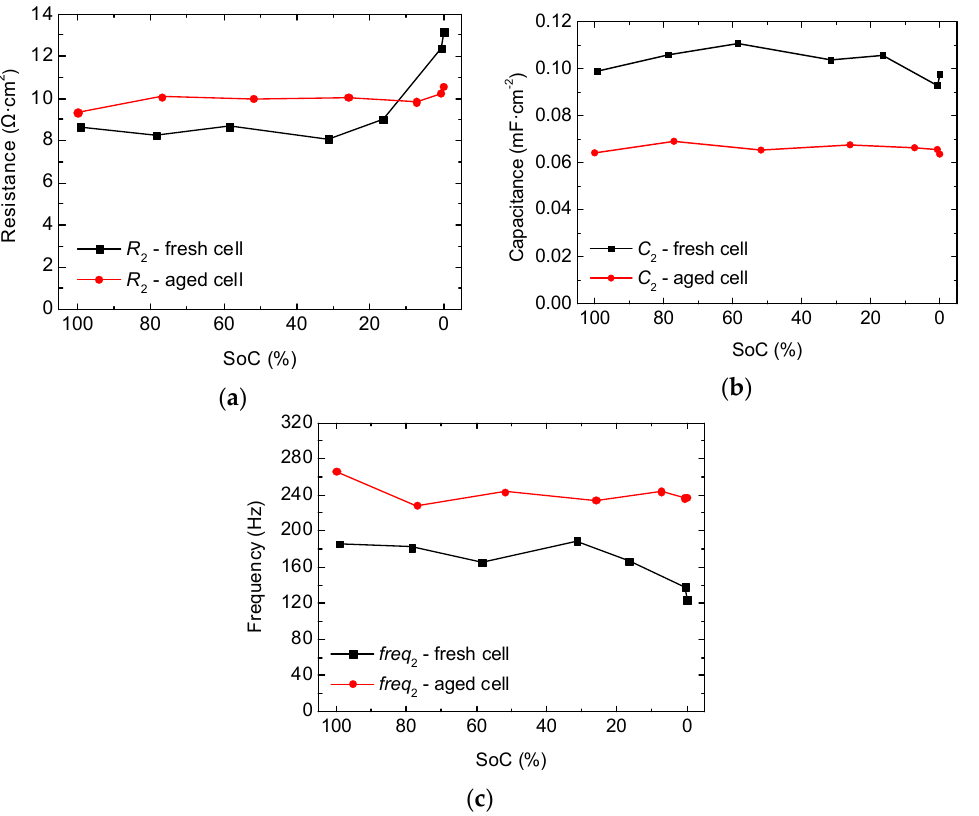
Figure 12. ( a ) Resistance, ( b ) capacitance, and ( c ) characteristic frequency related to P2_FC measured at the LCO-NMC/graphite full-cell at 25 ◦ C. This has been related to the transport of ions across the solid electrolyte interphase (SEI)